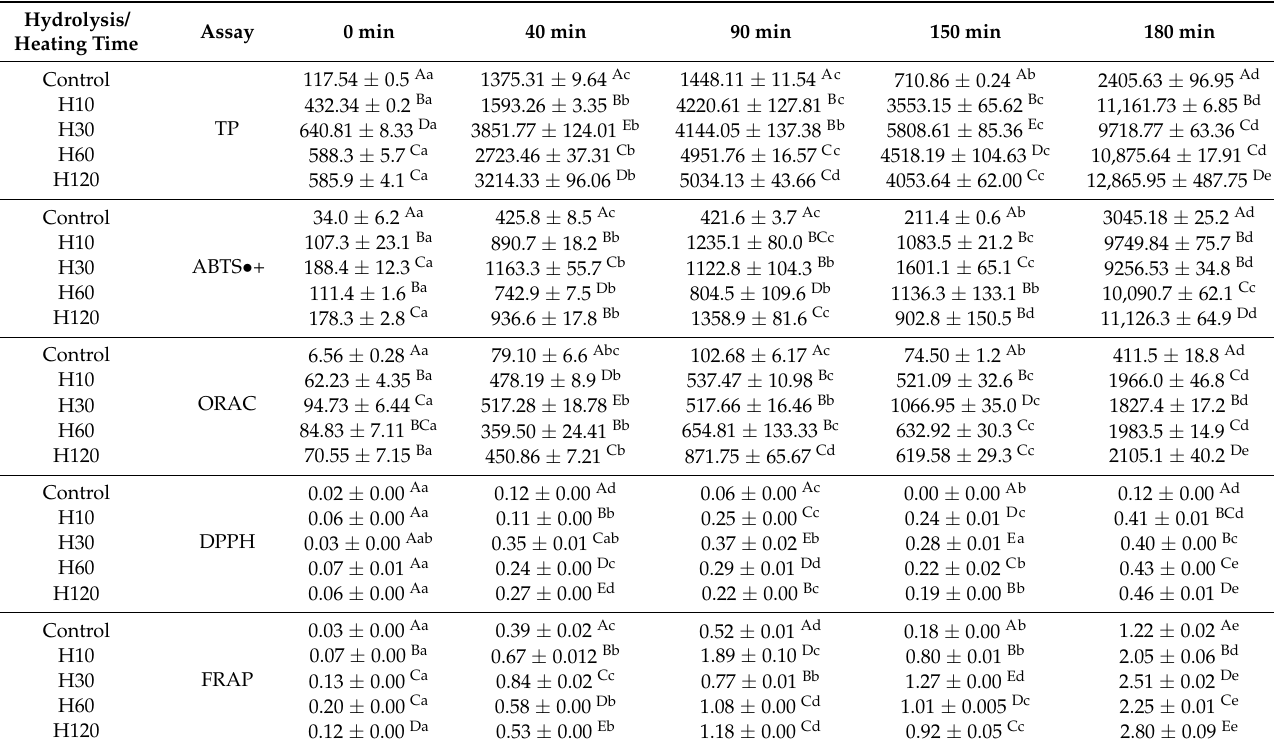
Table 3. Total phenol (TP, mEq GAE/100 g dry matter), total antioxidant activity as ABTS • +, ORAC, DPPH ( µ Eq Trolox/100 g dry matter), and FRAP (mEq Fe 2+ /100 g dry matter) of the samples before and after different glycation times (0, 40, 90, 150, 180